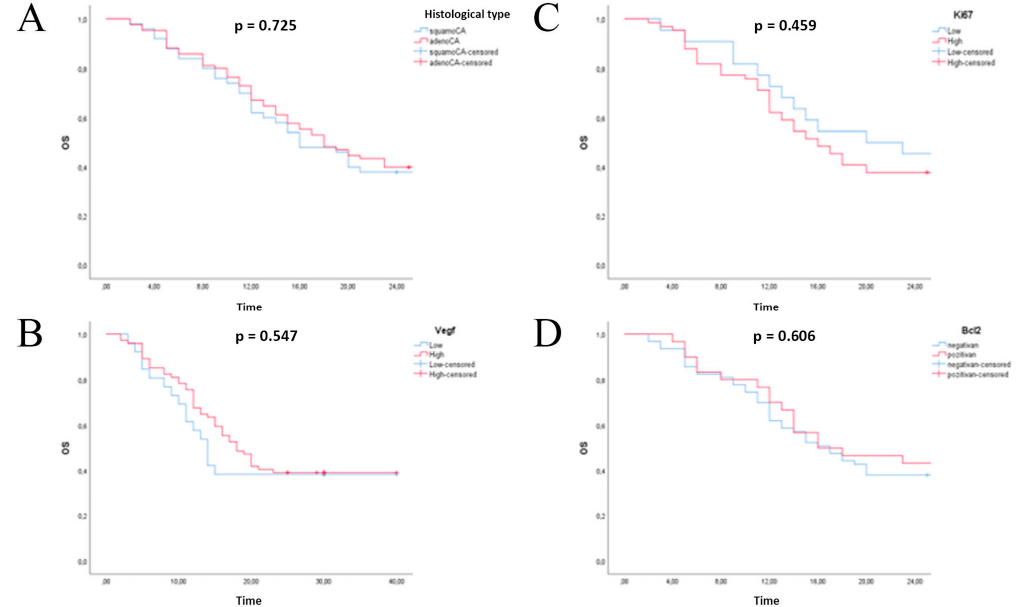
Figure 5. Kaplan-Meier overall survival analysis of patients with non-small lung cell carcinoma. ( A ) histology type; ( B ) expression status of VEGF; ( C ) expression status of Ki67; ( D ) expression status of Bcl-2.